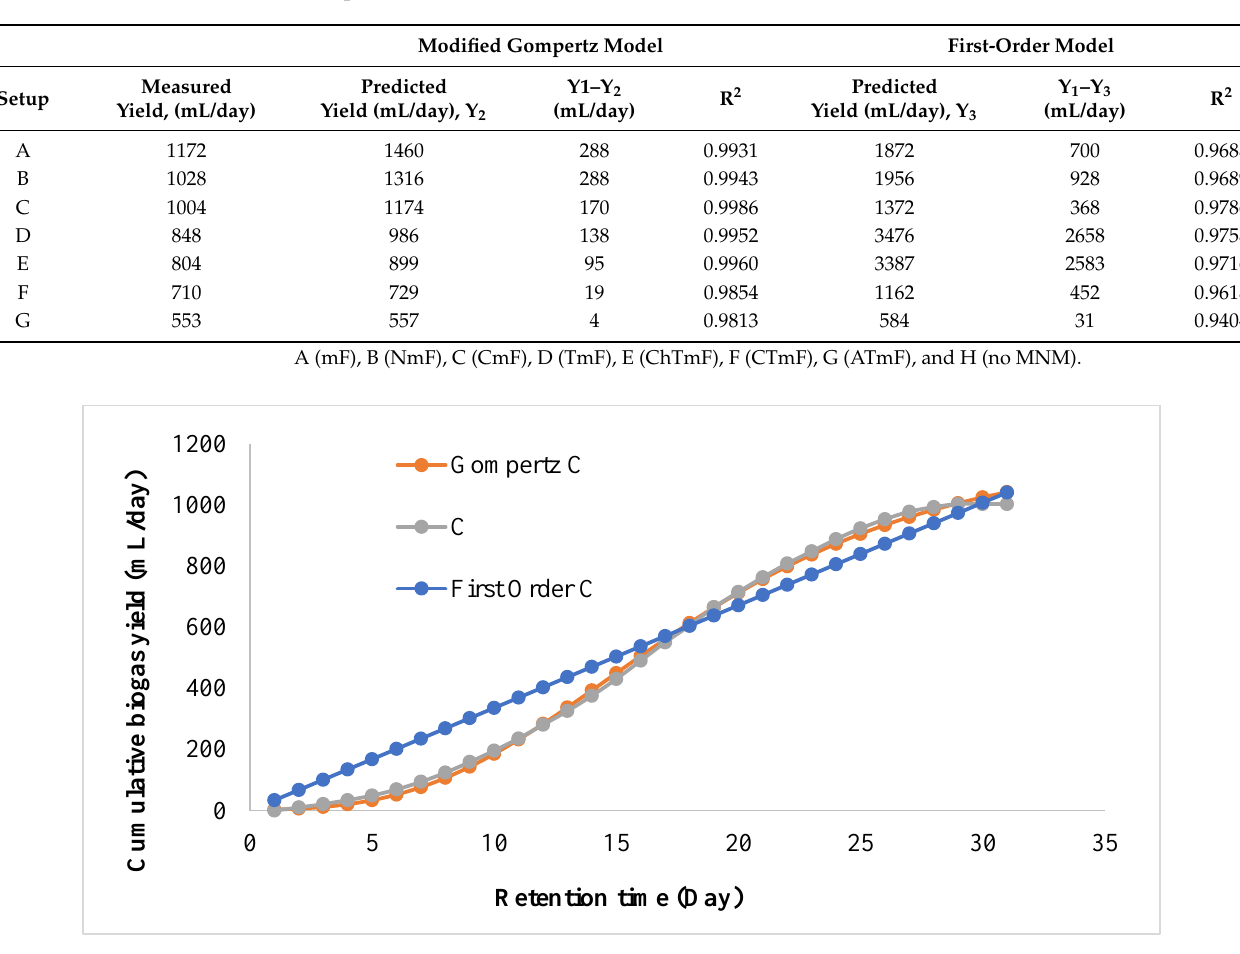
Table 4. Summary of the kinetic study for bioreactors: A (mF), B (NmF), C (CmF), D (TmF), E (ChTmF), F (CTmF), G (ATmF), and H (no MNM) fitted on first-order and modified Gompertz models.